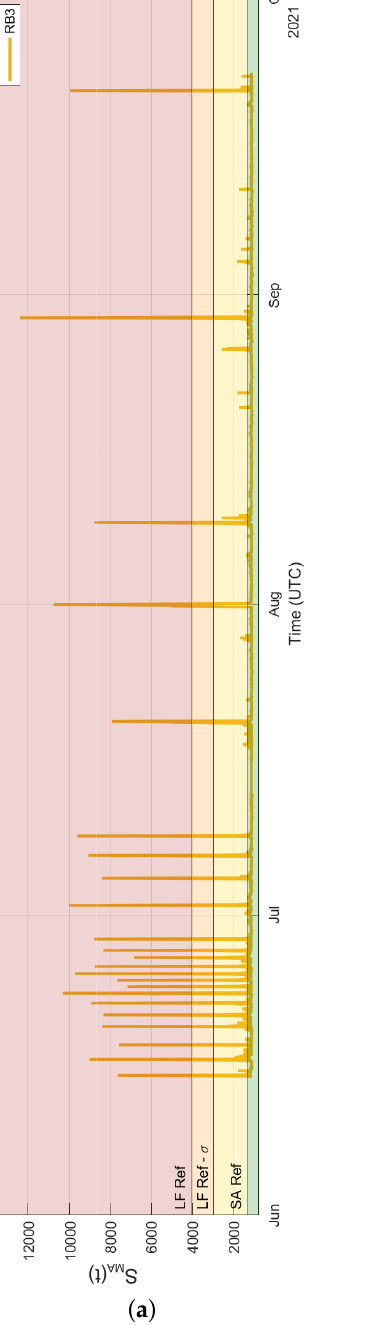
Figure 6. Radar time series acquired in real time from 14 June 2021 to 21 September 2021 for RB3 ( a ) and for RB4 ( b ). In both panels, the three consecutive thresholds for detecting the possible onset of the two volcanic phenomena (Strombolian activity and lava fountains) are reported. Above the reference value for the Strombolian activity ( SA Ref ), it is possible that the Strombolian activity is occurring at the SEC (yellow region); above the reference value for the lava fountains minus the standard deviation ( LF Ref − σ ), a lava fountain is possibly occurring at the SEC (orange region); above LF Ref , there is a strong possibility of a lava fountain at the SEC (red region). Every spike corresponds to one of the 23 considered eruptive episodes; if there is no activity, the radar time series stays below SA Ref (green